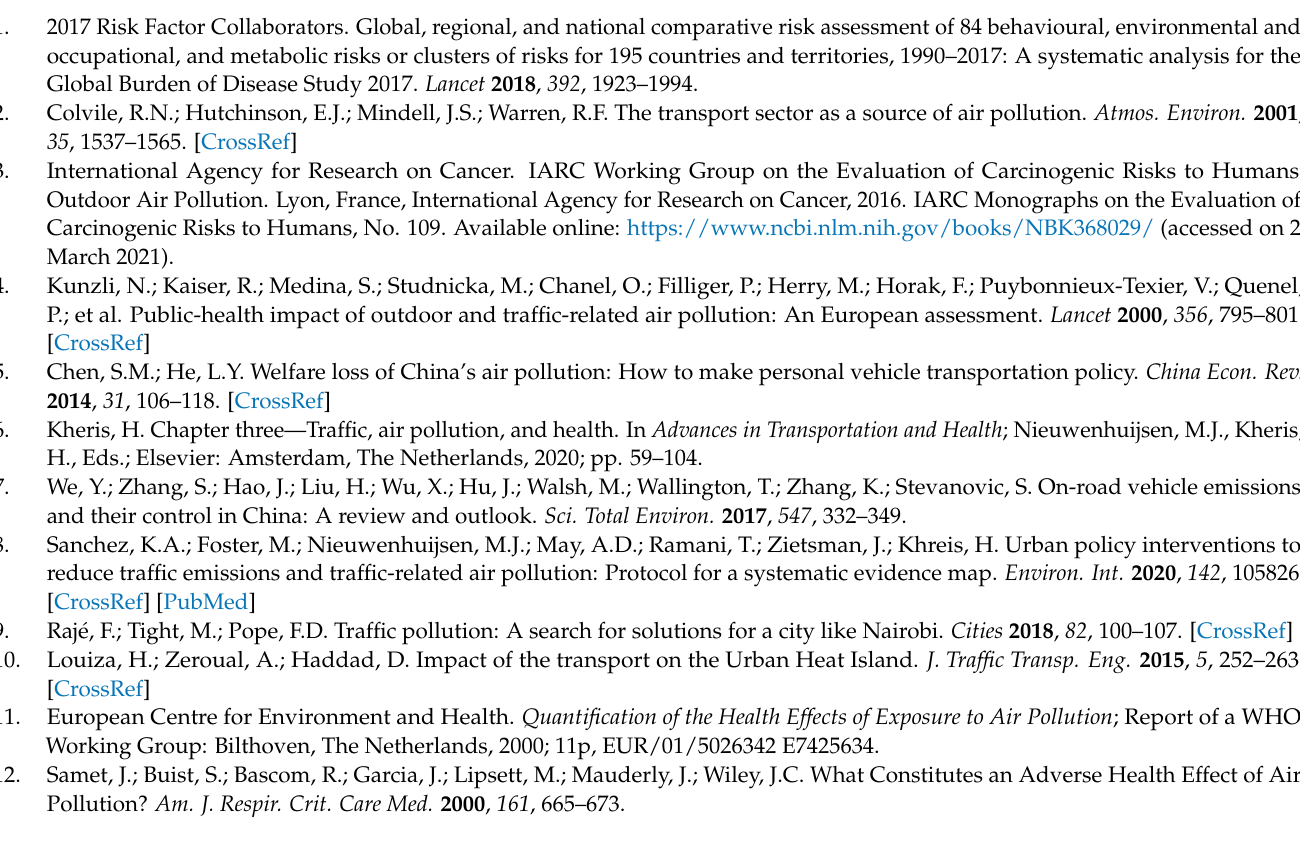
Population figures of 18 districts in Hong Kong, Figure S3: Example of handling long roads within Hong Kong (based on Section 2.3.1 (c)), Figure S4: Illustration of Inverse Distance Weighting (IDW) method in calculating traffic emission at position Y , which is in between two points, X and Z , with known emission